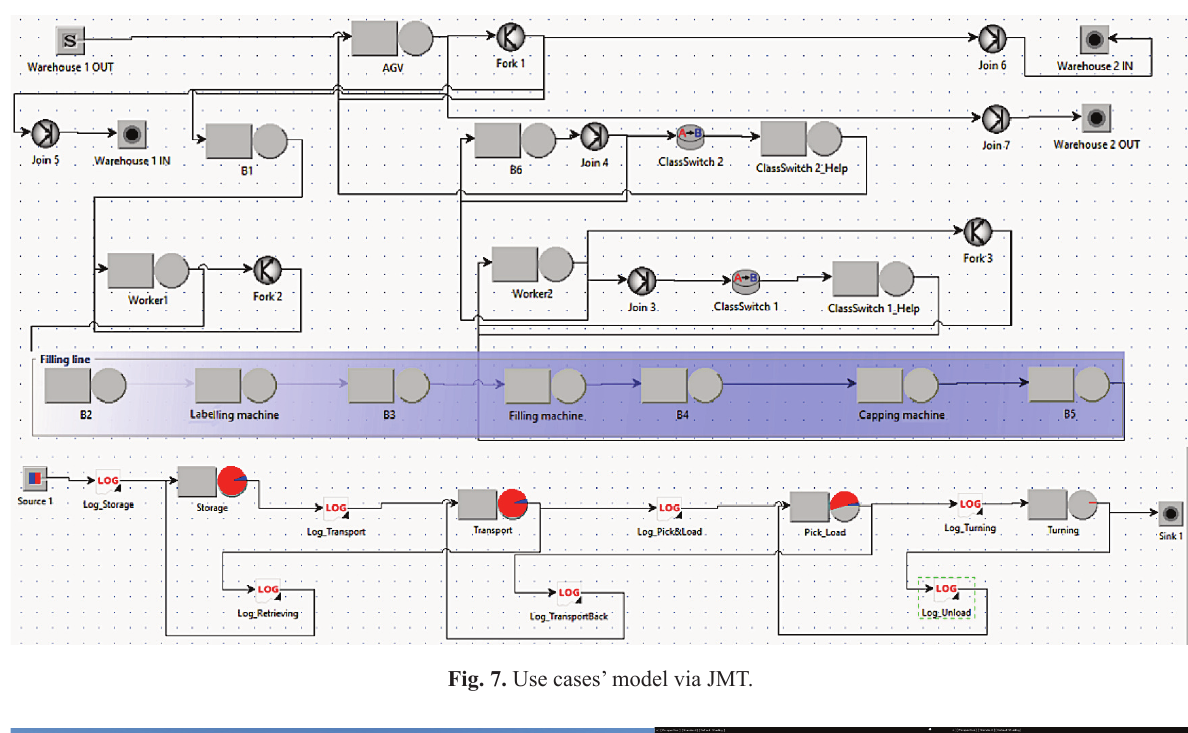
Fig. 7. Use cases’ model via JMT.